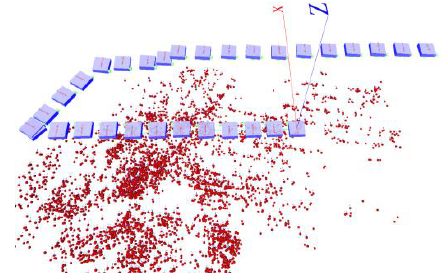
Figure 7. A local bundle block adjustment on Vihti dataset.